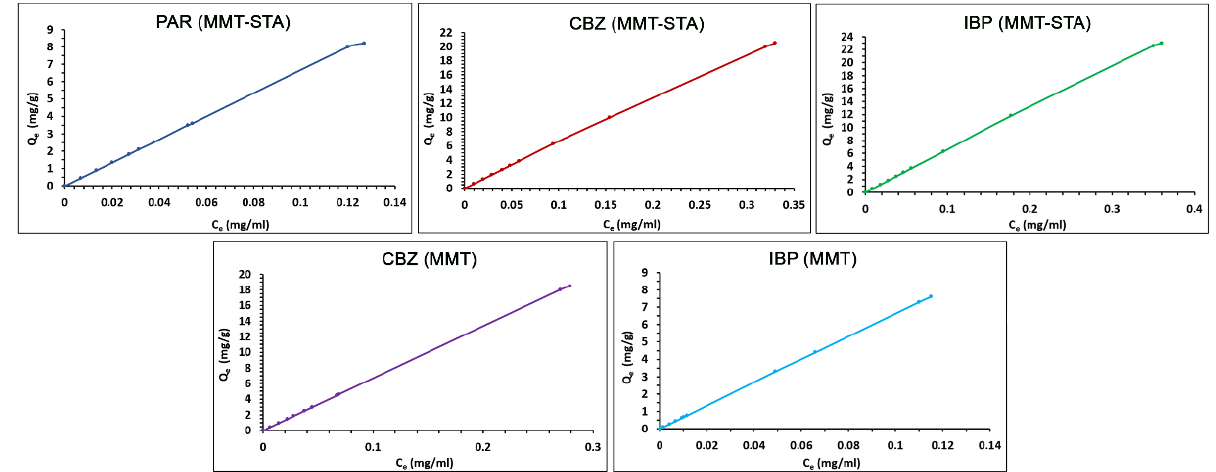
Figure 4. Adsorption isotherm of pharmaceuticals on clays.